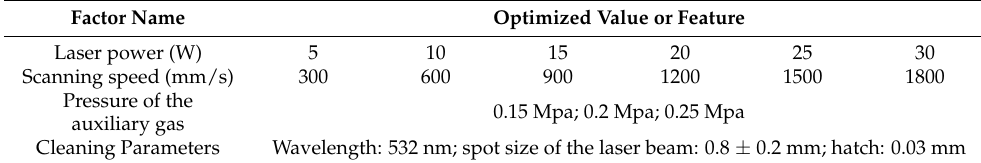
Table 3. Optimized parameters of laser cleaning processing parameters in each